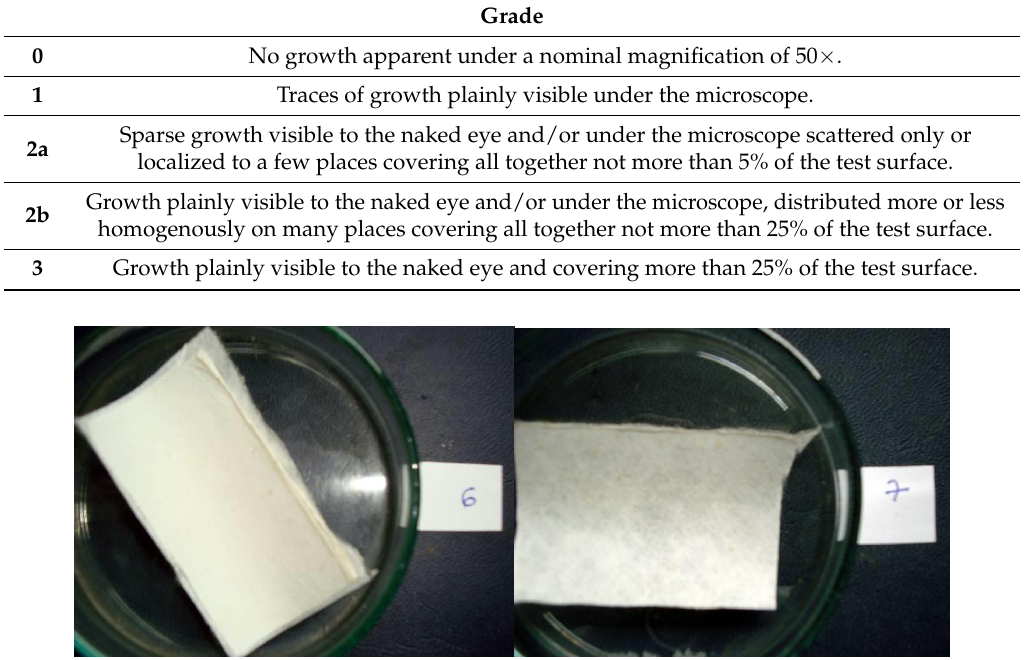
Figure 20. The appearance of filtration membranes from PVDF and PA-6 nanofibers after finishing the examination of resistance tomold, after 48 h exposition.